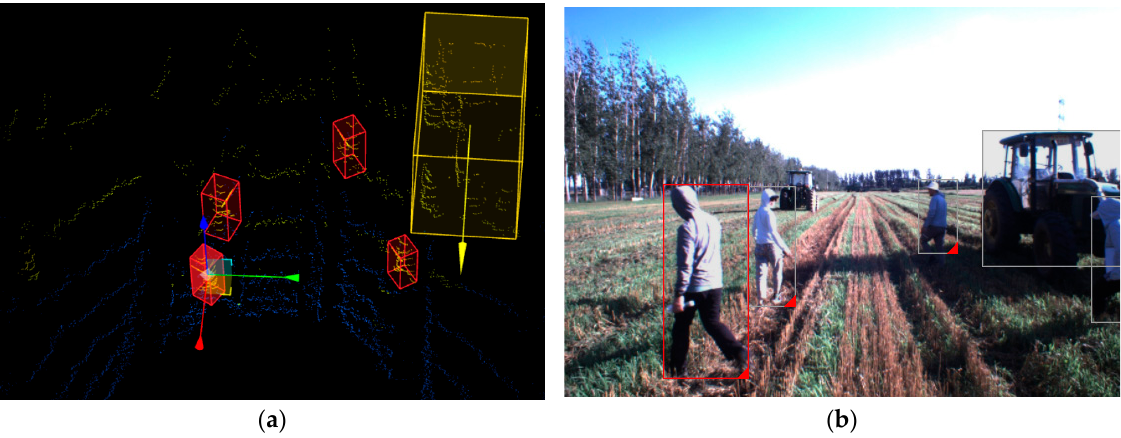
Figure 3. Examples of labeling operations. ( a ) Point cloud labeling; ( b ) Image labeling. Table 1. Dataset label format.